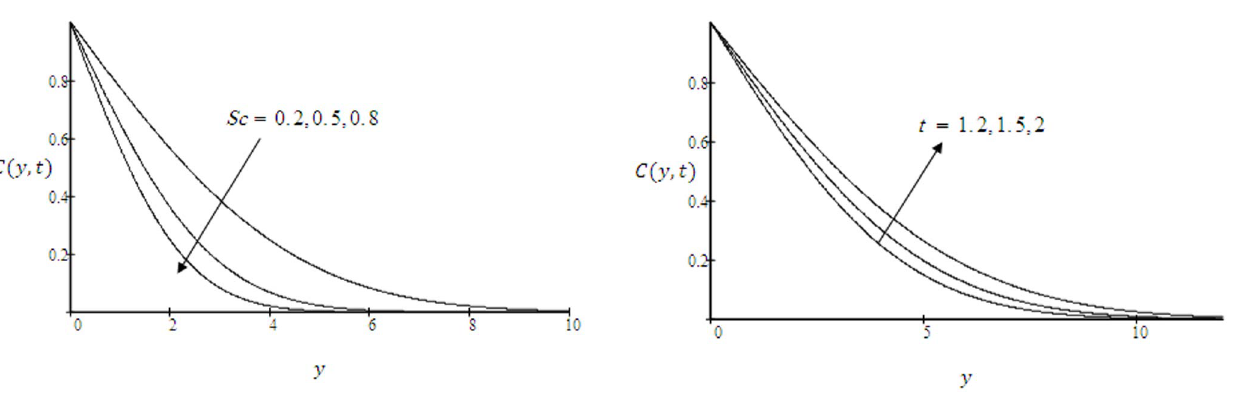
Figure 13. Concentration profiles for Sc ~ 0 : 2 and different values of t